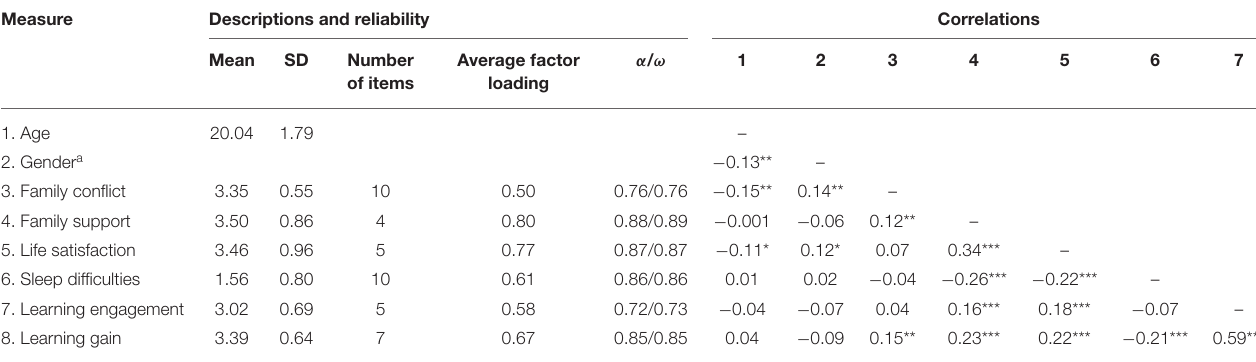
TABLE 1 | Results of descriptive, reliability, and correlational analyses.